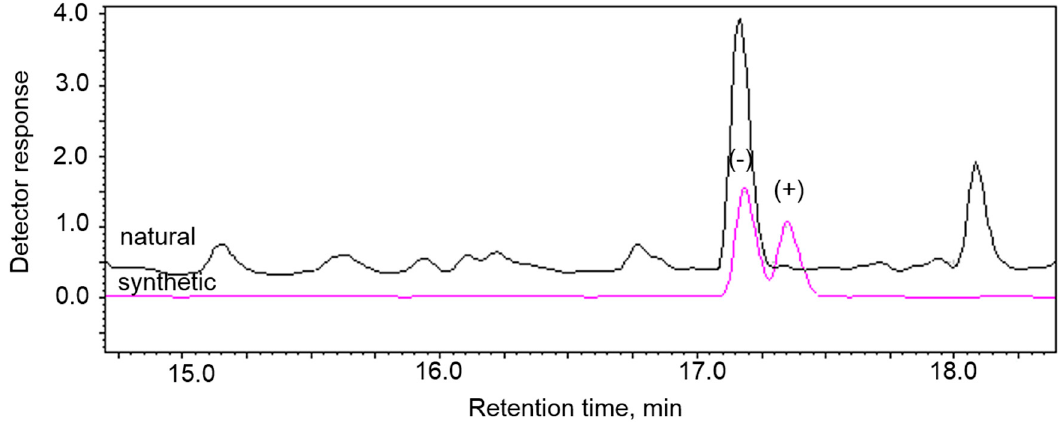
Figure 5. GC analyses of natural and synthetic enantiomers of δ -heptalactone on chiral Rt ® -bDEXsm capillary column.